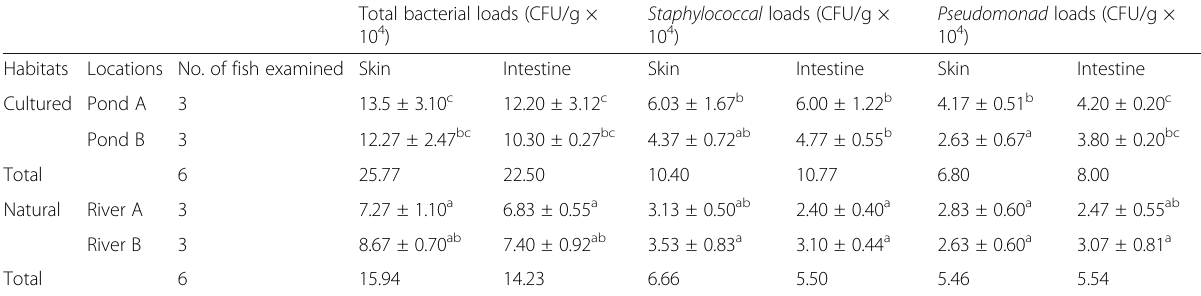
Table 1 Total bacterial, Staphylococcal and Pseudomonad loads of C. gariepinus from cultured and natural habitats Total bacterial loads (CFU/g × 10 4